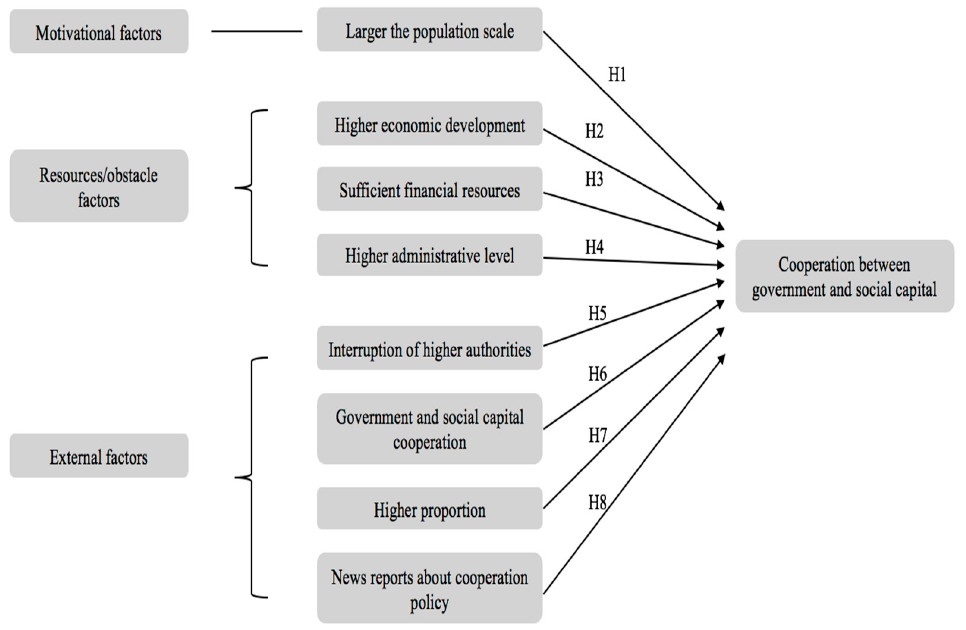
Figure 2. Conceptual framework of the study.